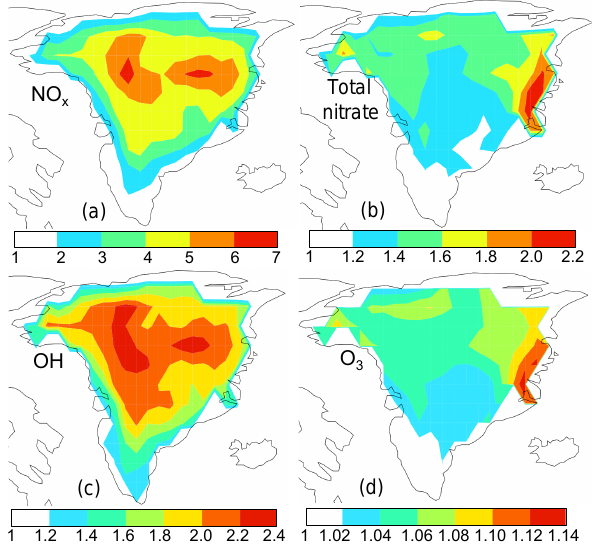
Figure 9. Factor increase in mean summer (JJA) boundary layer (a) NO x , (b) gas + aerosol-phase nitrate, (c) OH, and (d) O 3 mixing ratios between model runs with F NO